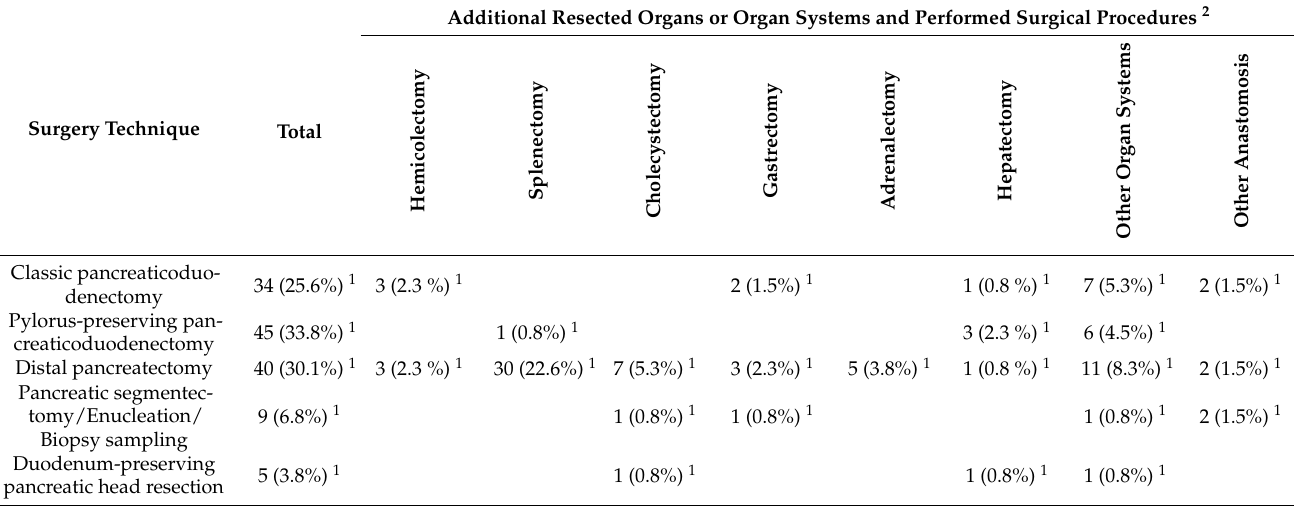
Table 1. Overview of the applied surgery techniques and any additional surgical